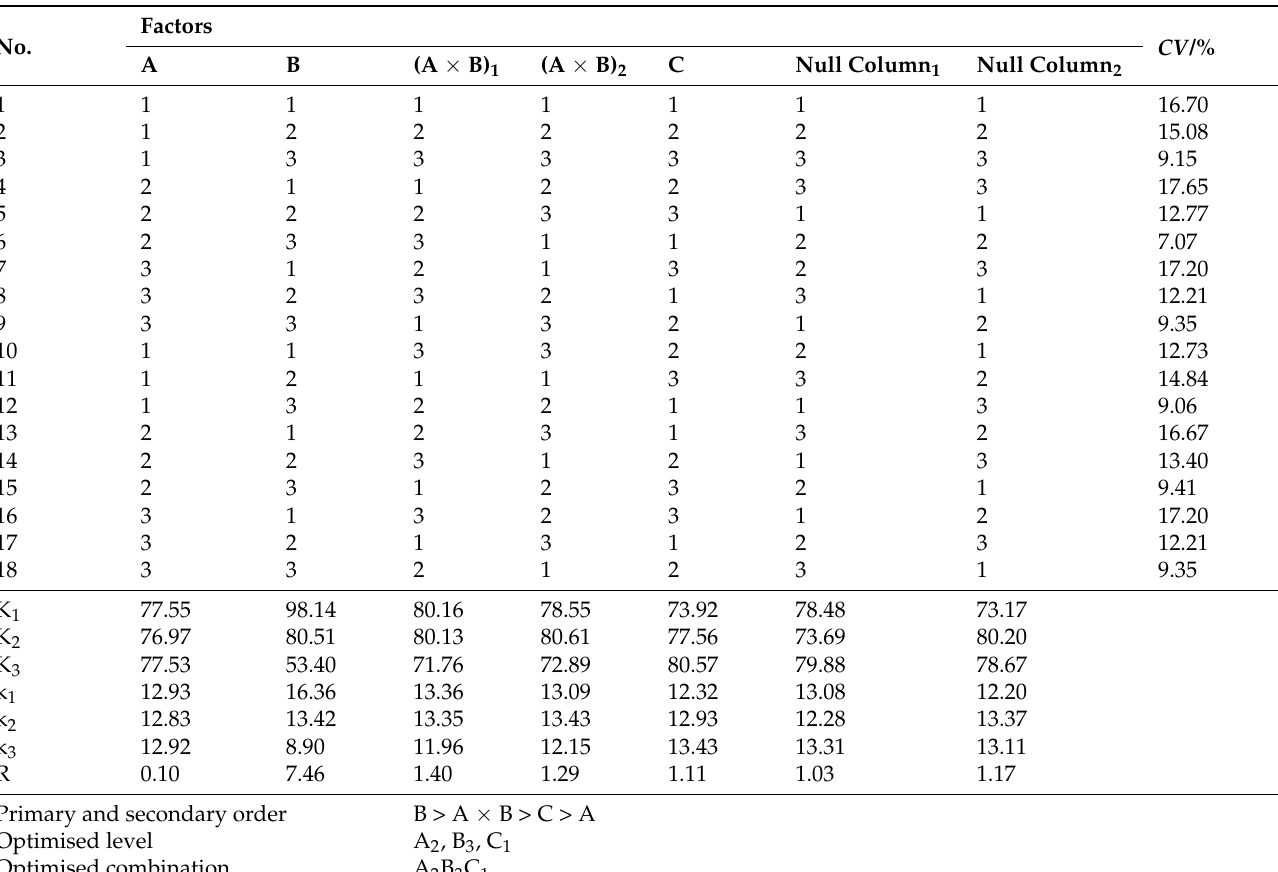
Table 2. Results of the orthogonal test.